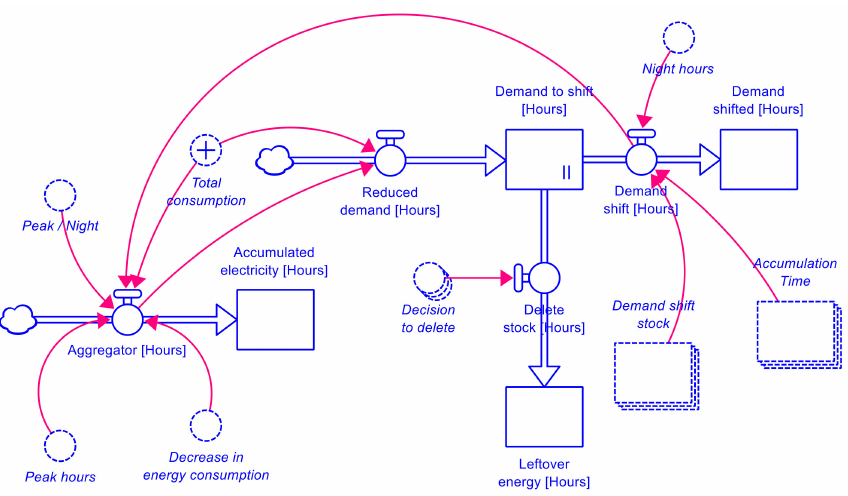
Figure 9. Load shifting sub-model for Aggregator